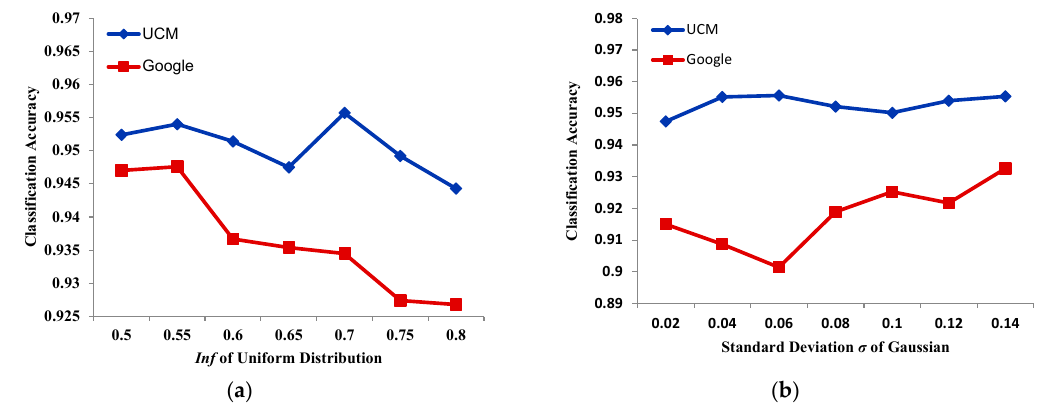
Figure 14. ( a ) The relationship between inf of the uniform distribution and classification accuracy. ( b ) The relationship between the standard deviation α of the Gaussian distribution and classification accuracy.